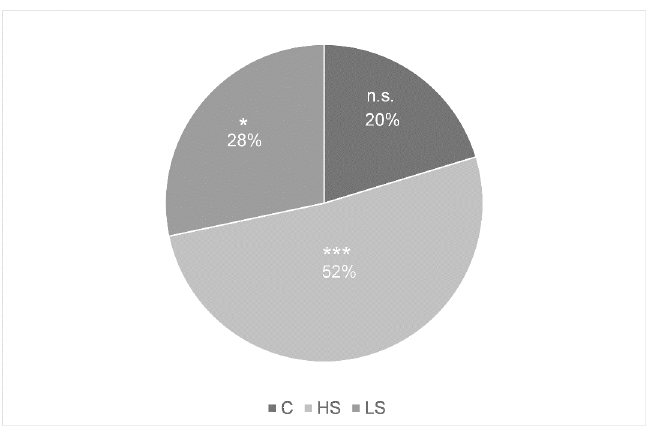
Fig 4. Change in objective effort (OE) from TT b to TT i given in percent change. (cid:3) p < .05, (cid:3)(cid:3)(cid:3) p < .001.